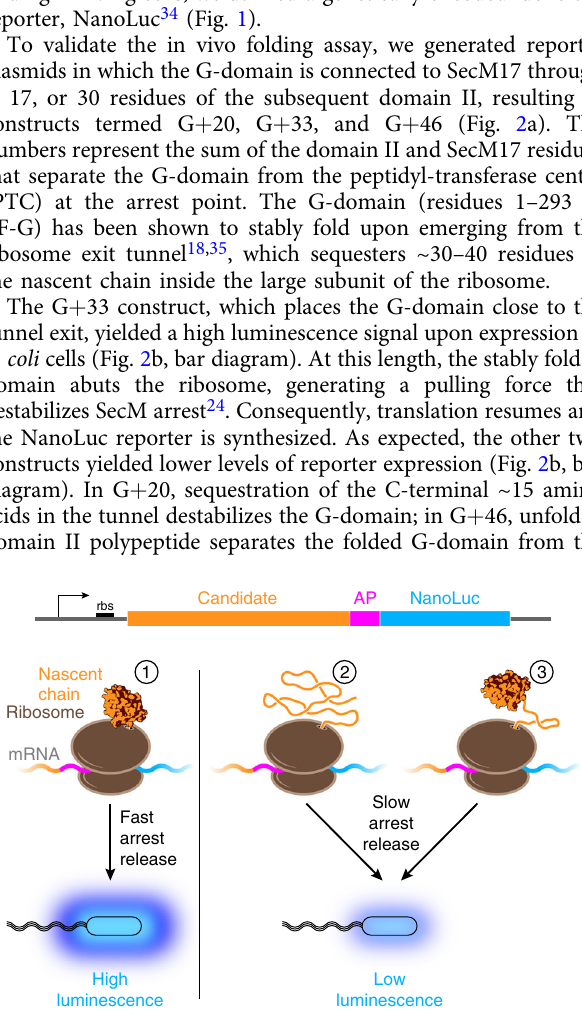
Fig. 1 NanoLuc reporter assay for monitoring nascent chain folding in vivo. Plasmids for expression in E. coli encode candidate proteins fused to the SecM arrest peptide (AP) and the NanoLuc reporter (diagram on top). Upon expression in host cells, nascent chain synthesis is arrested at the end of the AP. When the candidate is folded and in close proximity to the ribosome at the arrest point ( ➀ ), force on the nascent polypeptide inside the ribosome exit tunnel accelerates arrest release. Accumulation of the full-length fusion protein that includes NanoLuc results in high luminescence. When the candidate protein is not stably folded ( ➁ ) or when it is separated from the ribosome by an unfolded segment ( ➂ ), arrest release occurs more slowly, and cells exhibit low